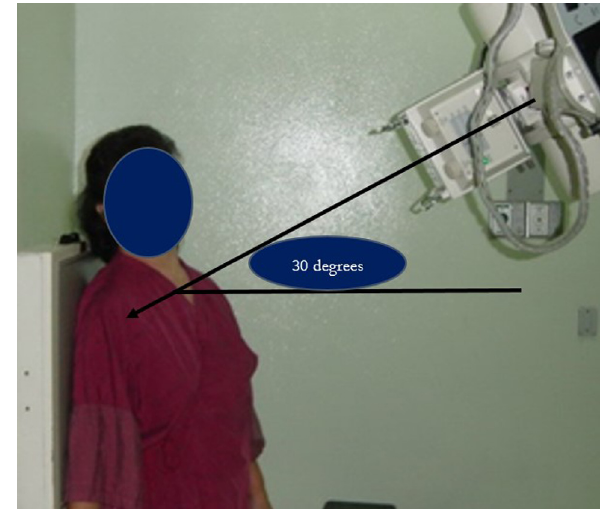
Figure 1. Standard position for the Rockwood tilt view film. The film was placed behind the shoulder of the patient, who was standing 35 cm between the cassette and the source. The X-ray beam was projected from the anterior direction at a 30 (cid:2) tilt from superior to